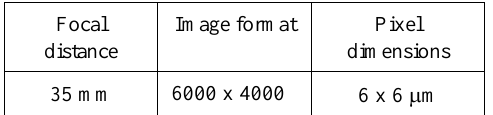
Table 2. Main characteristics of Sony - RX1 digital camera